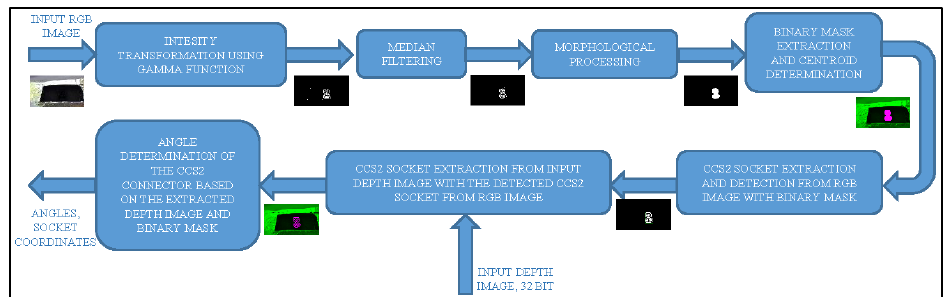
Figure 3. Block diagram of the proposed algorithm.